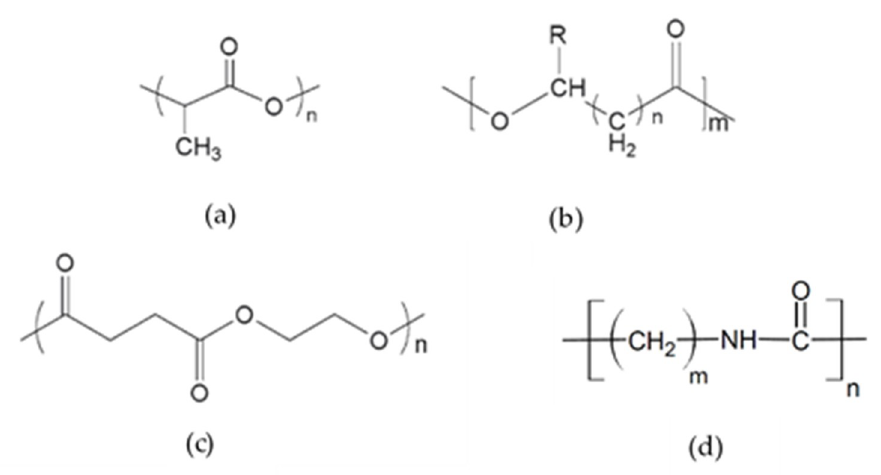
Figure 7. Chemical structure of ( a ) Polylactic acid (PLA), ( b ) Polyhydroxyalkanoate (PHA), ( c ) Poly butylene succinate (PBS), ( d ) Polyamide (PA). Adapted from [120–123].